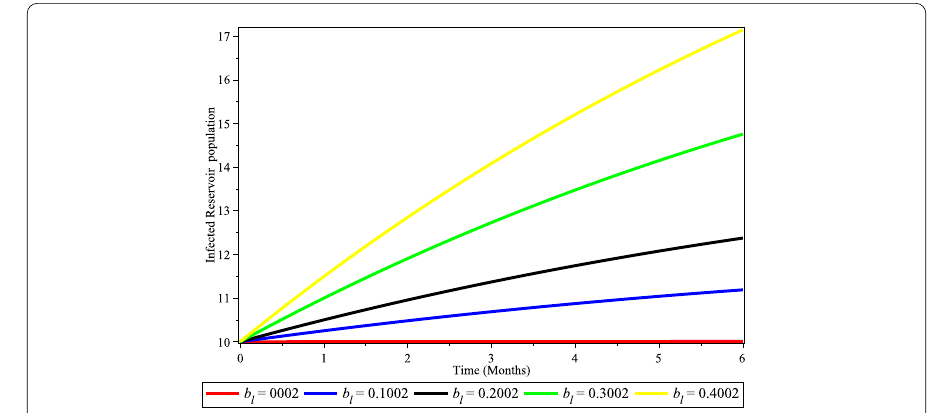
Figure 7 Effect of recovery rate of HIV–VL on co-infectious